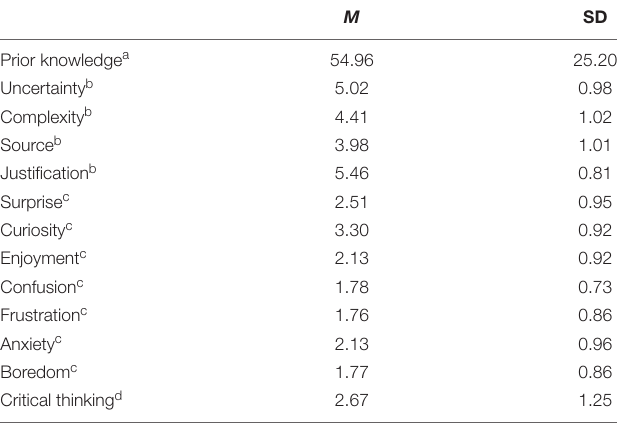
TABLE 3 | Descriptive statistics for